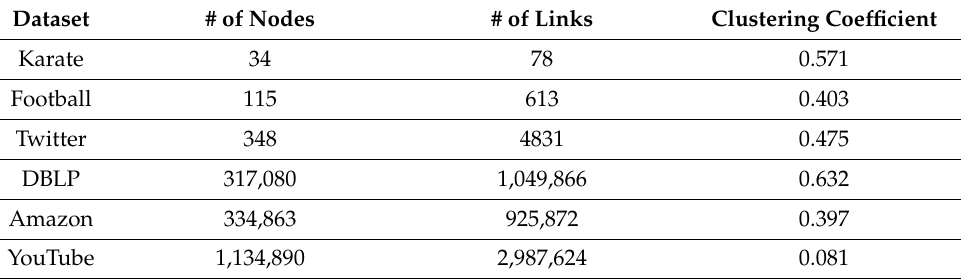
Table 1. Real-world network datasets.